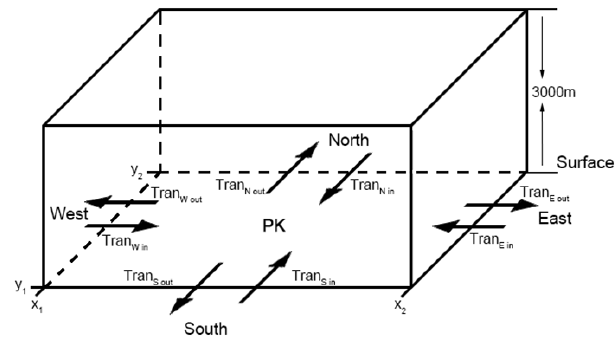
Figure 7. Schematic diagram of pollutant transport between BJ and its surrounding